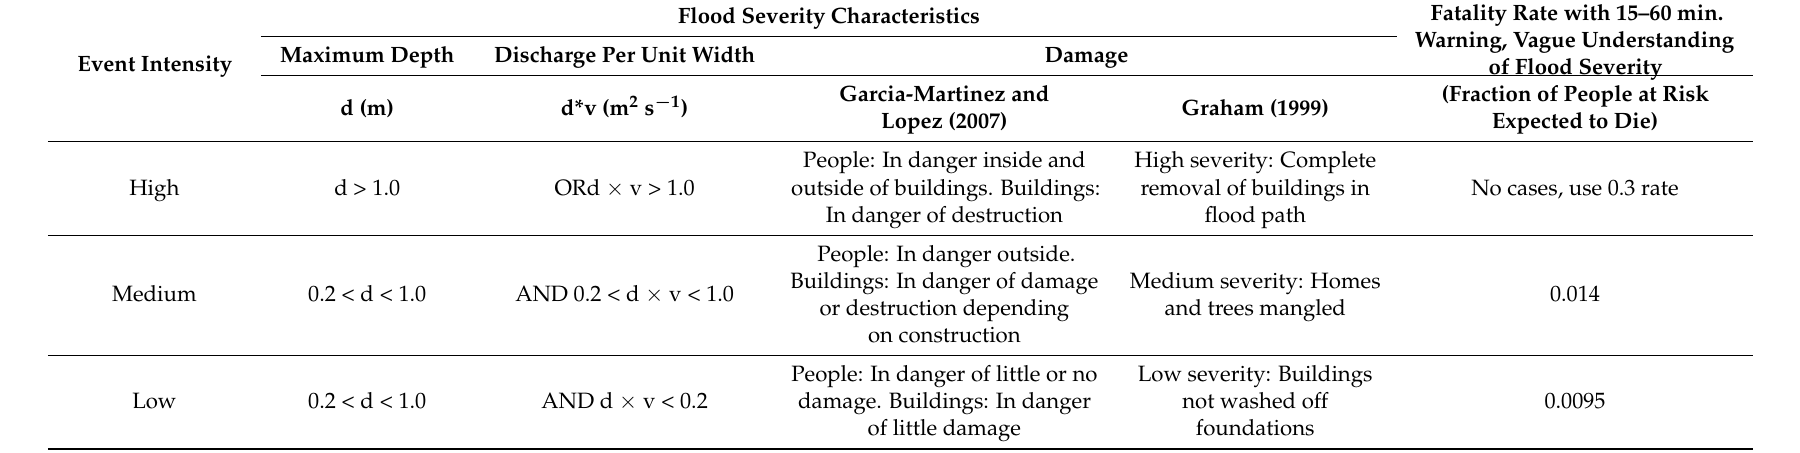
Table 1. Debris flow event intensity, flood severity characteristics, and fatality rates (data from Garcia-Martinez and Lopez (2007) [41] and Graham (1999) [40]).